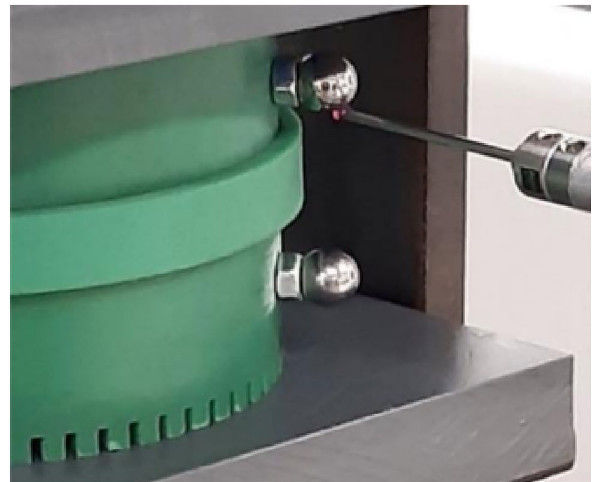
Figure 12. Probe measuring the position of a bearing ball.